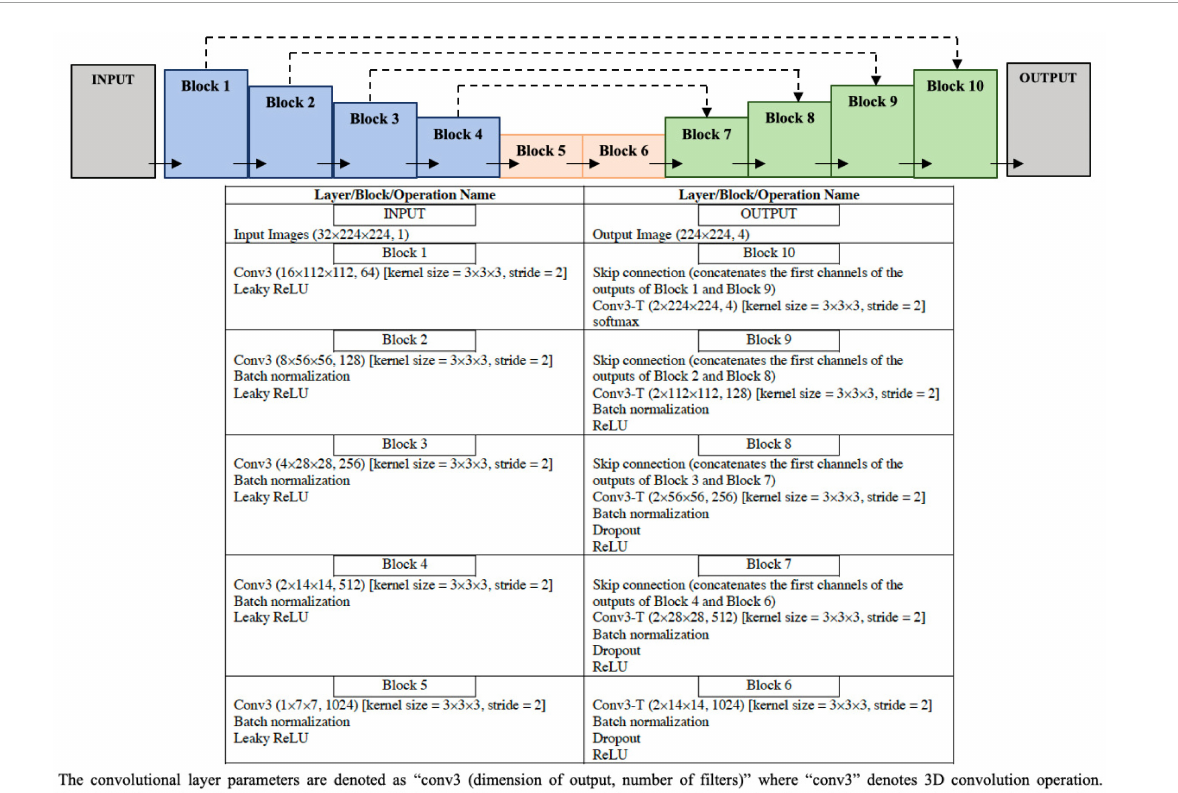
FIGURE4 Configuration of the ResNet50 architecture to predict the binary outcome of presence or absence of myocardial scar using the set of 32 cine short axis image frames as input to the